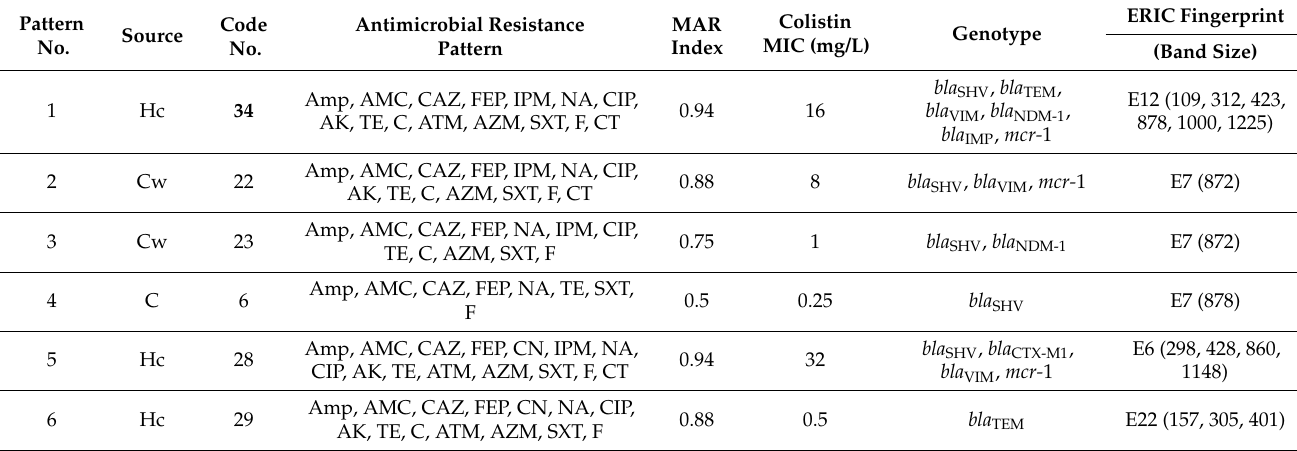
Table 2. Antimicrobial resistance phenotypes, their associated genes and ERIC fingerprinting patterns of hypervirulent ESBL and carbapenemase-producing K. pneumoniae isolates from chickens and humans in this study. Pattern